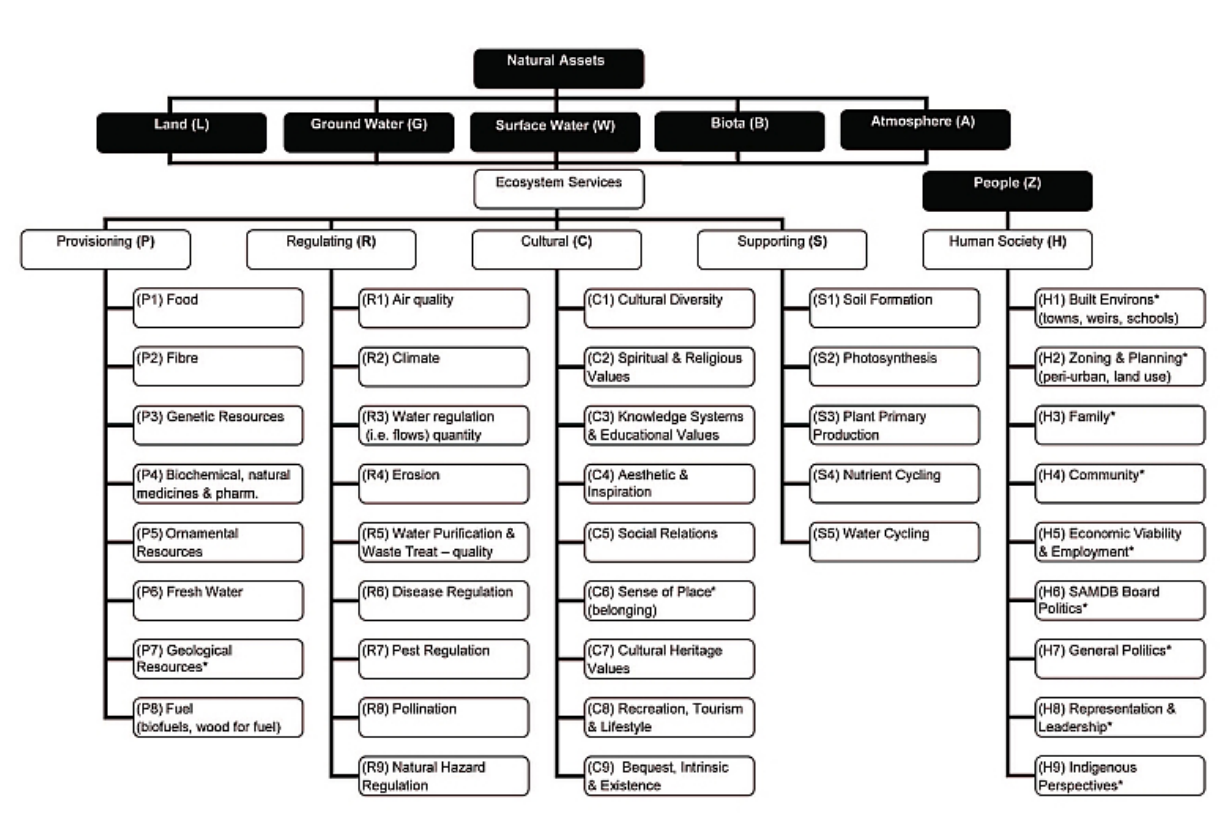
Fig. 2 . Coding matrix.